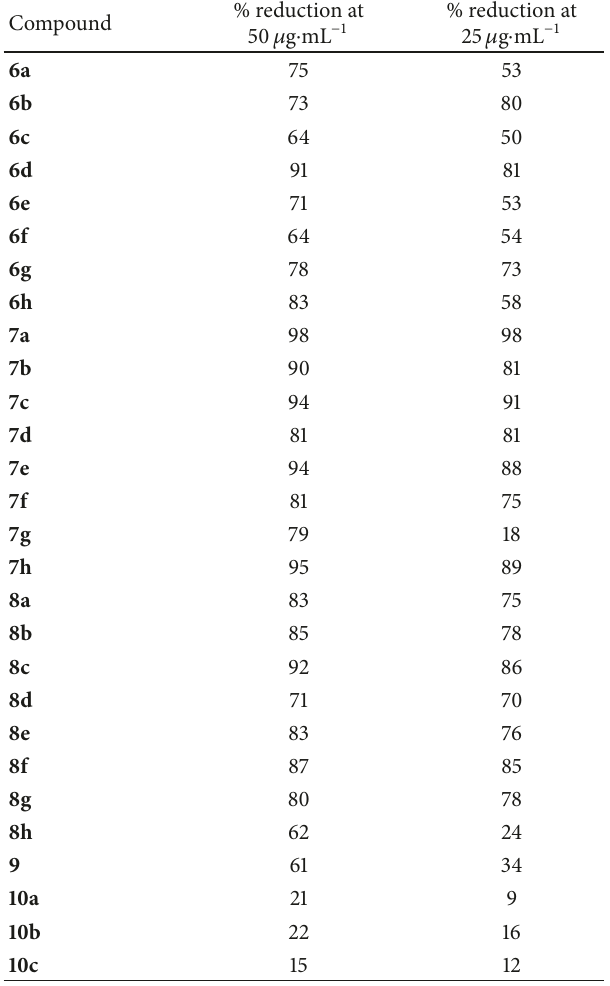
Table 1: Percentages of Plasmodium falciparum (W2)